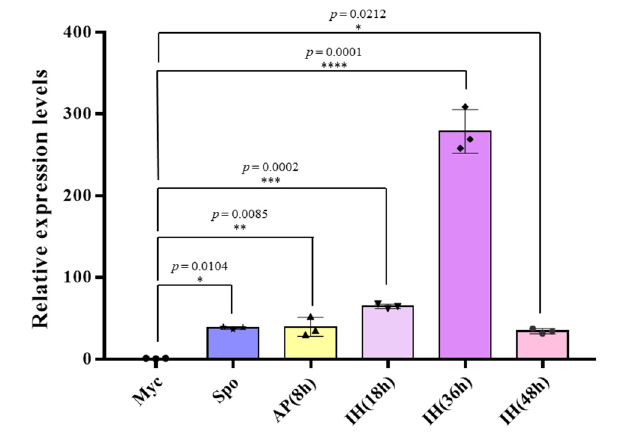
Figure 2. Expression pattern of MoPtep1 in different stages. Samples from vegetative (mycelium and spore) and invasive stages (8, 18, 36, 48 hpi) of barley epidermis were performed by qRT-PCR. Myc: mycelium; Spo: spore; AP: appressoria; IH: invasive hyphae. The bar represents the standard error of the three technical duplications. Significance analysis was analyzed by Student’s t -test, and * indicates p < 0.05, ** indicates p < 0.01, *** indicates p < 0.001, and **** indicates p < 0.0001.